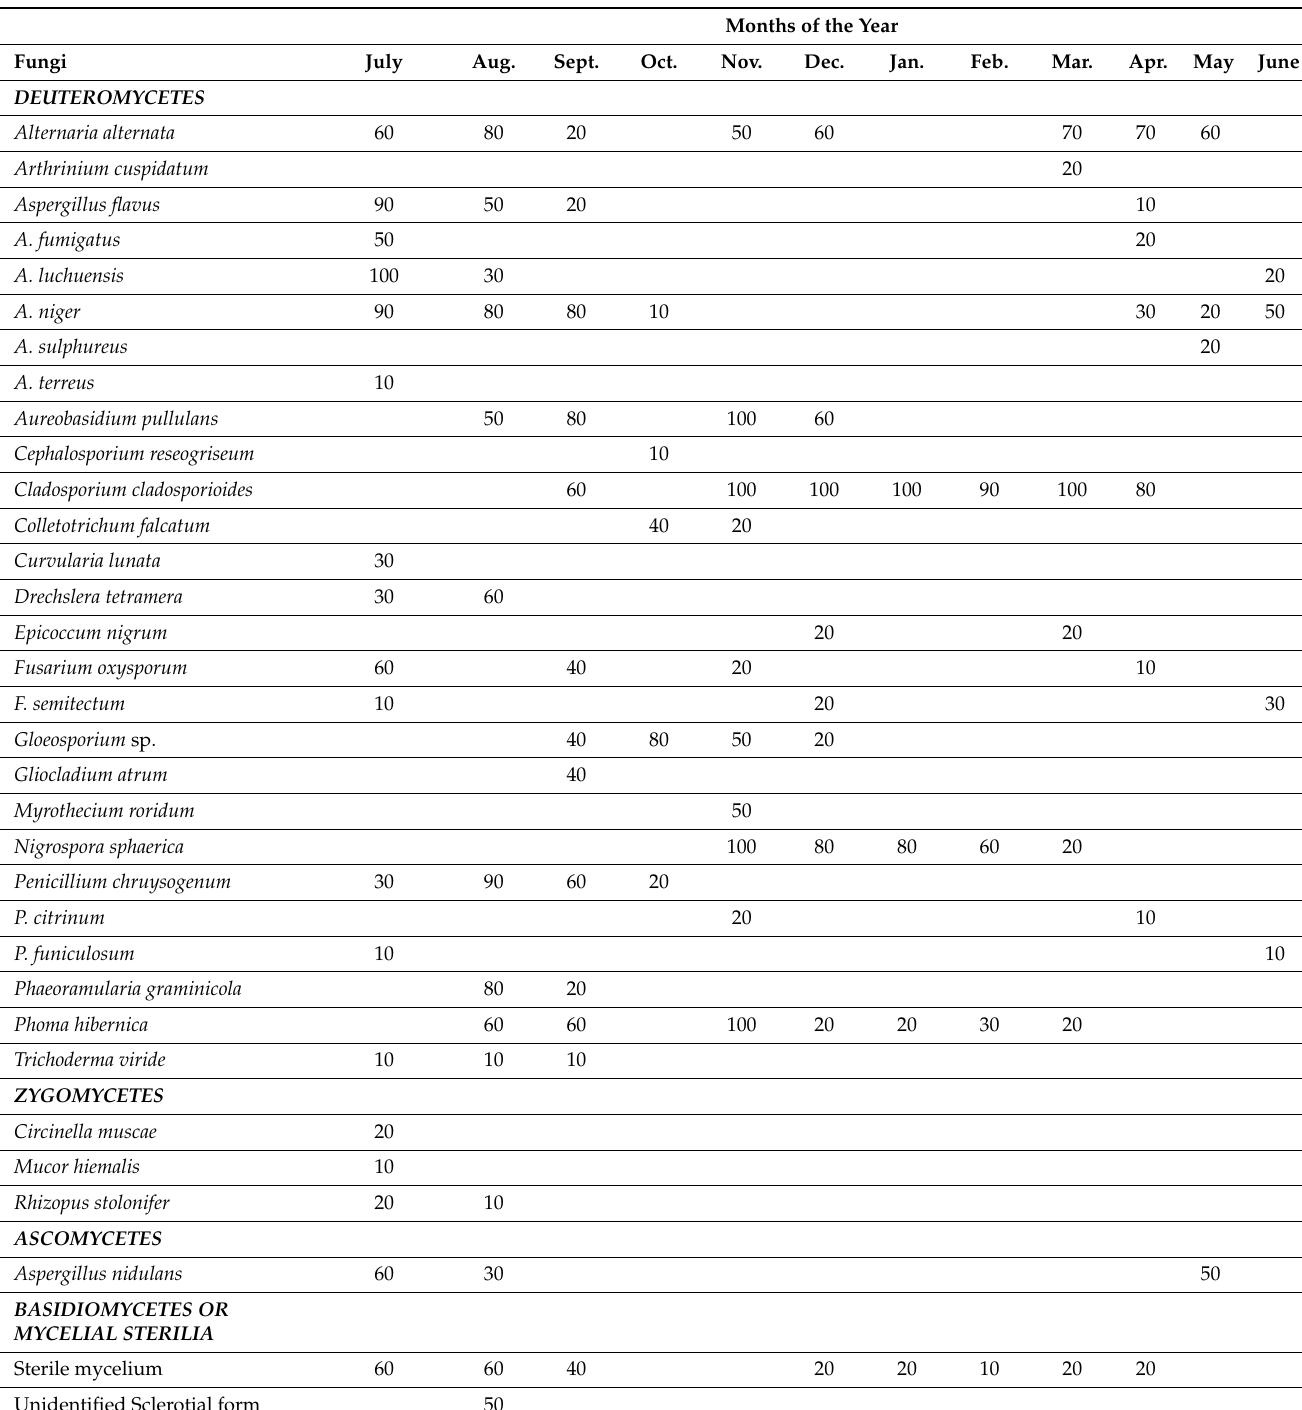
Table 2. Percentage frequency of occurrence of various fungi on yellow attached Leaves